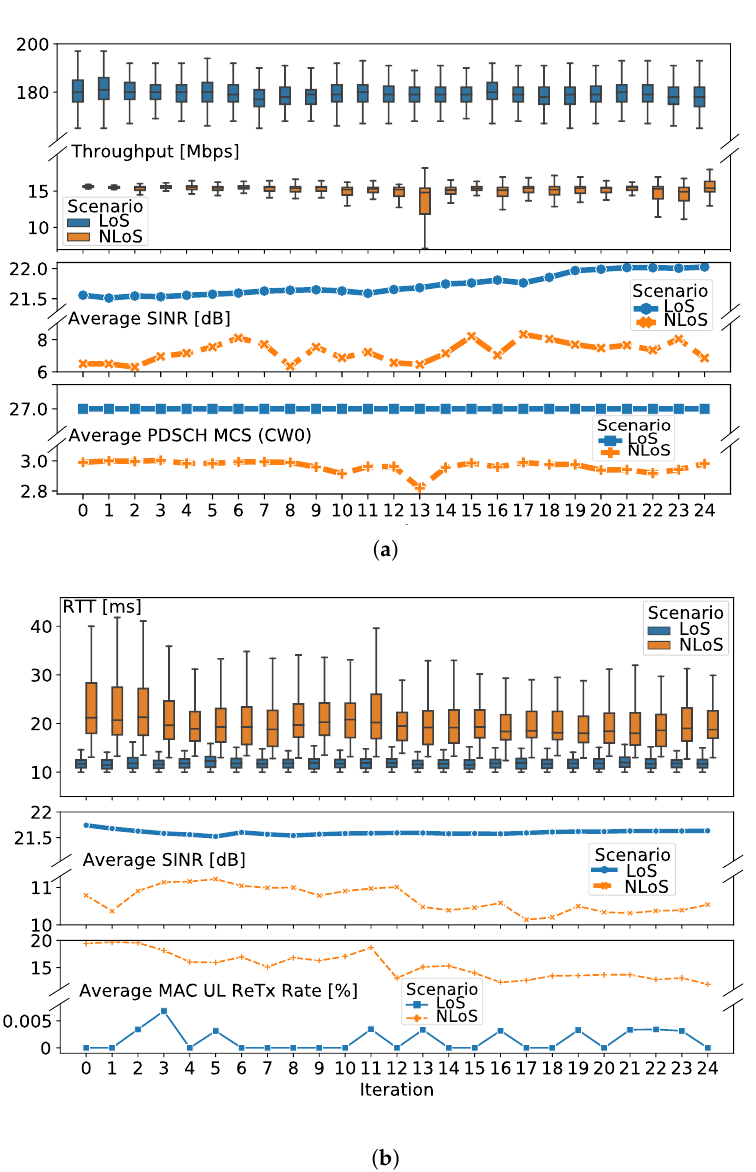
Figure 4. Experiment 1: Per-iteration statistics in SC_LoS_PS and SC_NLoS_PS scenarios and UE_1. UDP Throughput ( top ), average SINR ( middle ) and average PDSCH MCS CW0 ( bottom ) are reported for TC_THR_UDP test case ( a ). RTT ( top ), average SINR ( middle ), and average MAC UL ReTx Rate ( bottom ) are reported for TC_RTT test case ( b